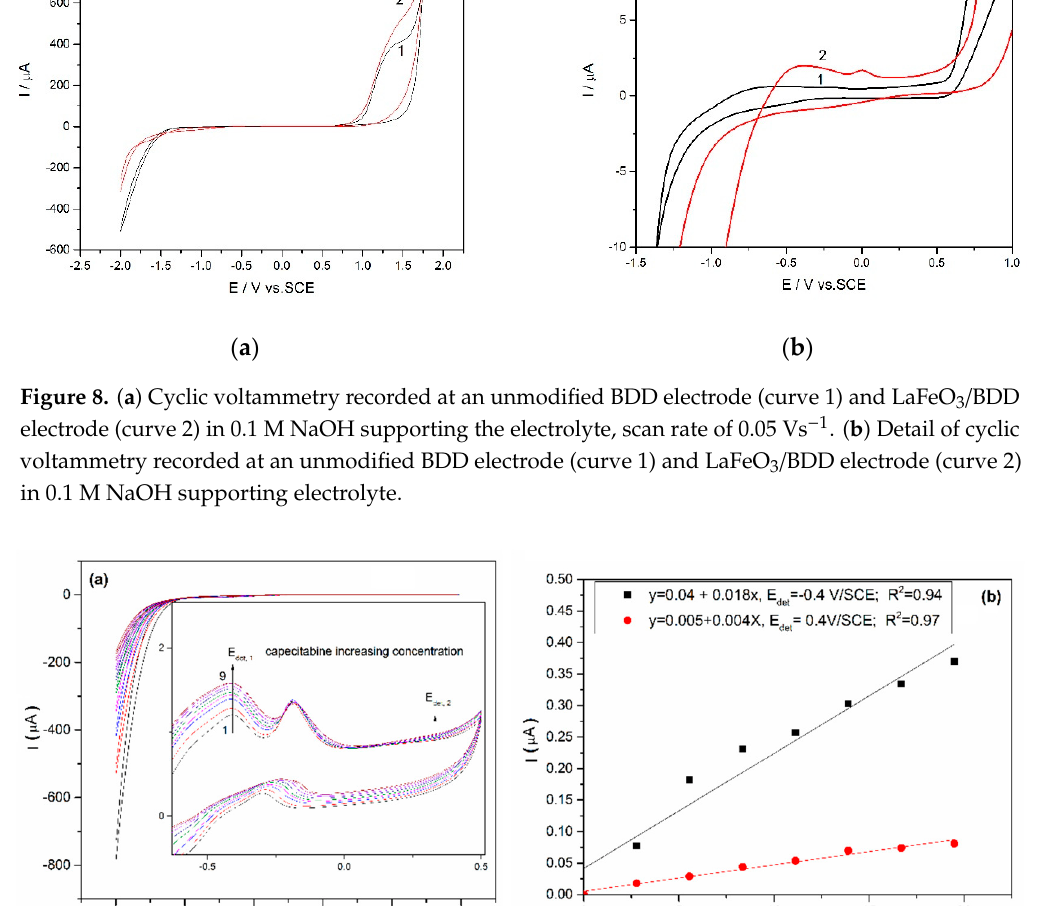
Figure 10. Differential-pulsed voltammograms recorded at LaFeO 3 /BDD electrode in 0.1 M NaOH (curve 1) and in the various CCB concentrations ranged from 2.5 µM to 17 µM (curves 2-7), scan rate of 0.05 Vs − 1 , modulation amplitude of 0.2 V, and step potential of 0.05 V.